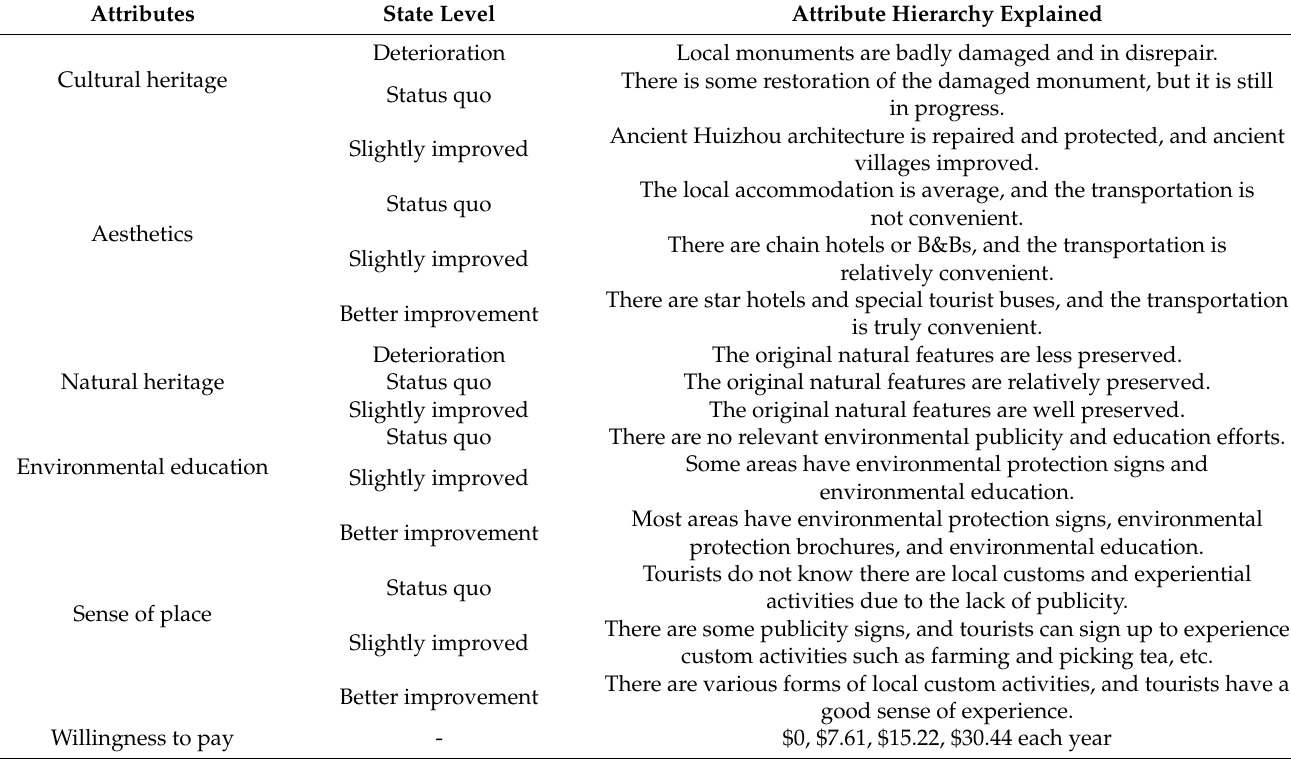
Table 2. Cultural ecosystem service attributes and levels of the choice